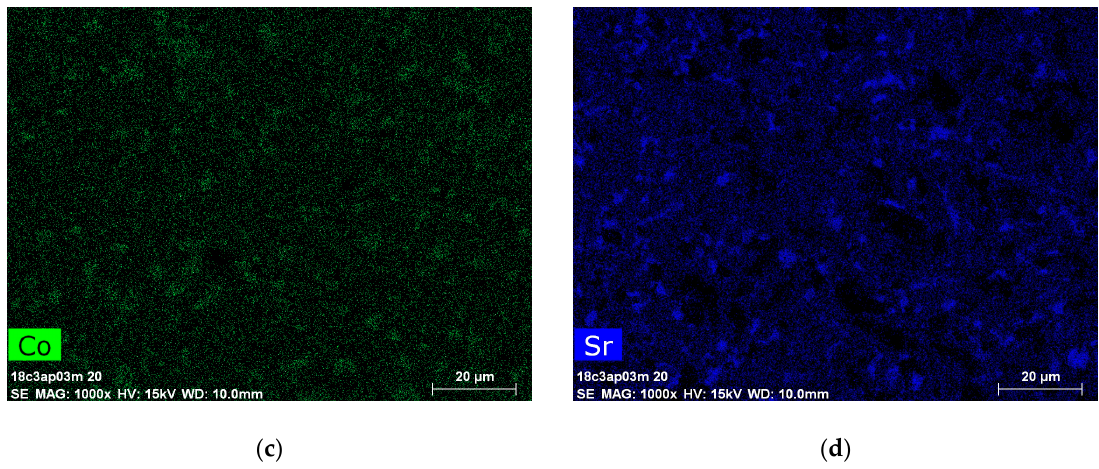
Figure 4. SEM image of cross-section of bulk Sr 3 Co 2 Fe 24 O 41 ( a ) and color maps of the elements (Fe-red ( b ), Co-green ( c ) and Sr-blue ( d )).